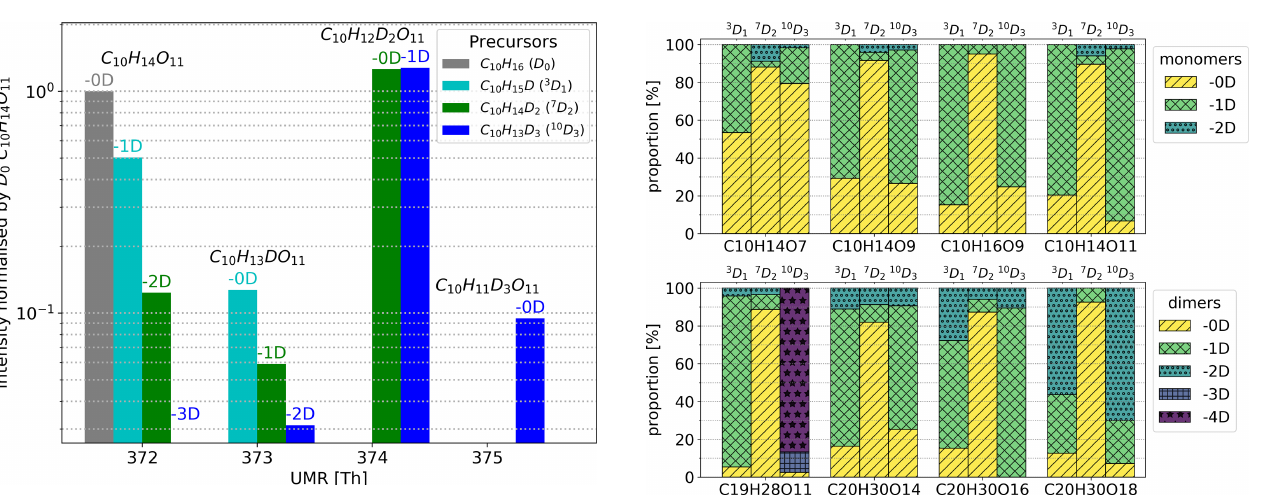
Figure 6. Isotopic distributions of chosen HOMs as proportions of signals using high-concentration C high data. The colours show ) is at how many deuterium atoms are lost from the molecule during the 3 formation process. For example, in the case of 3 D 1 precursor and C 10 H 14 O 7 compounds, − 0D corresponds to C 10 H 13 DO 7 and − 1D corresponds to C 10 H 14 O 7 . The entries for − 3D and − 4D are ex- cluded from the upper legend as there were no corresponding com- pounds in the inspected